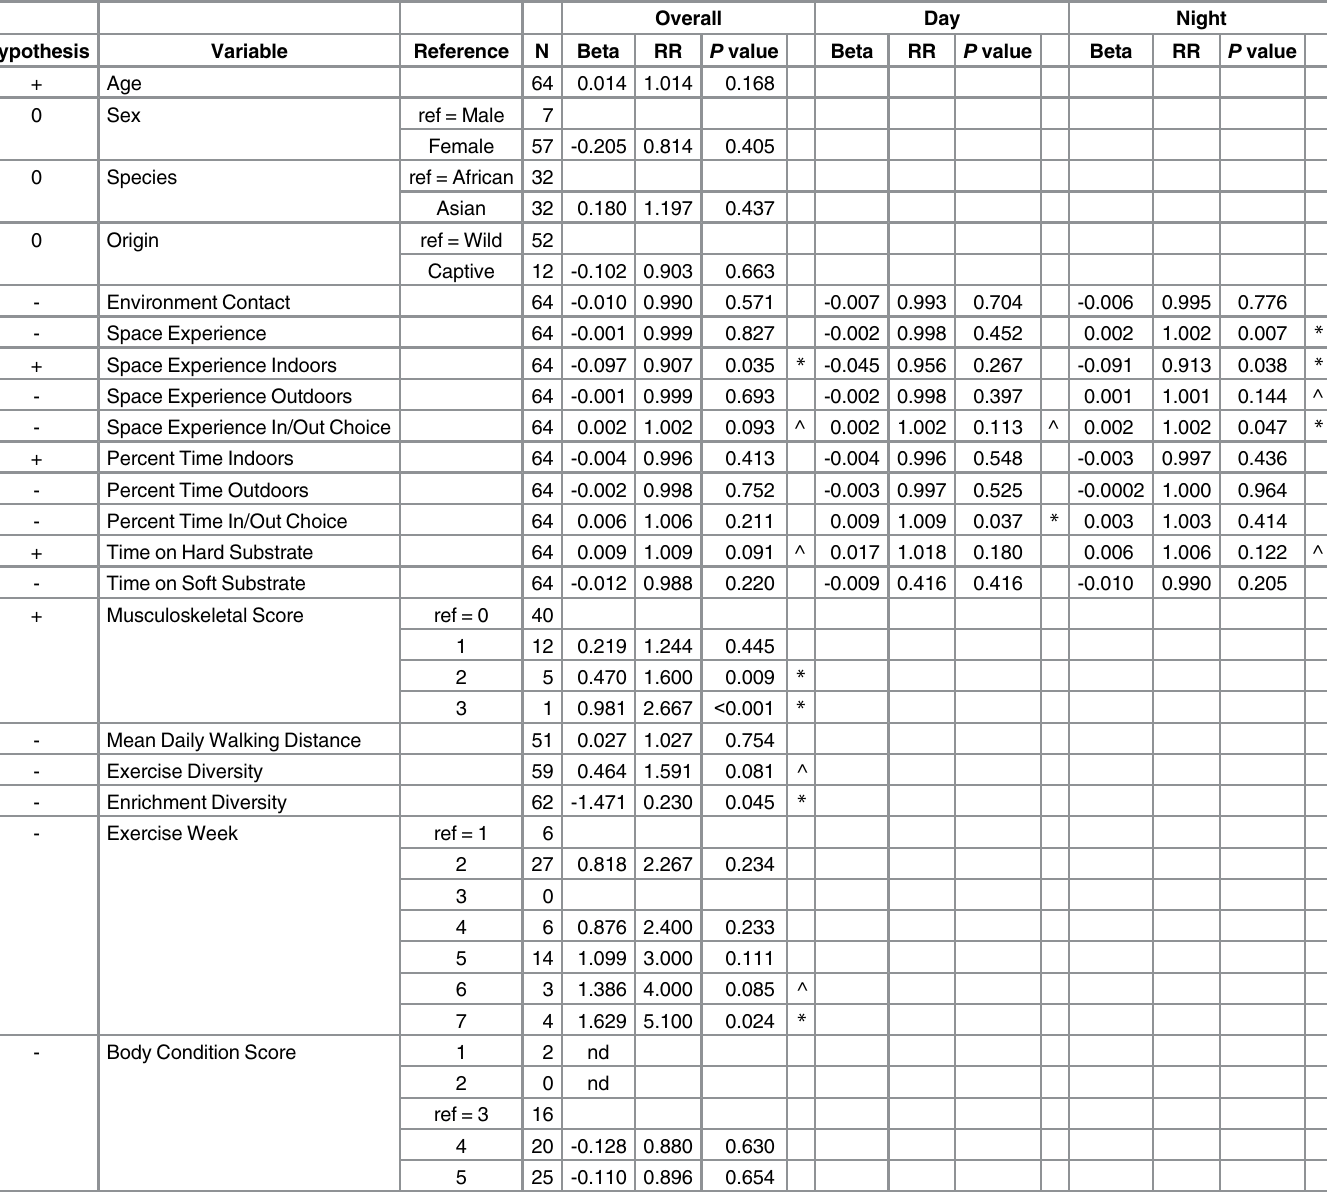
Table 7. Univariate assessment of possible persistent foot scores for African and Asian elephants using Poisson regression. RR: Risk Ratio; nd: no data, * : P value < 0.05; ^ P value < 0.15 significance threshold for model building. Hypothesis: + Increase risk of having increased PPF score; — Decrease risk of having increased PPF score; 0 Neutral relationship on PPF score.